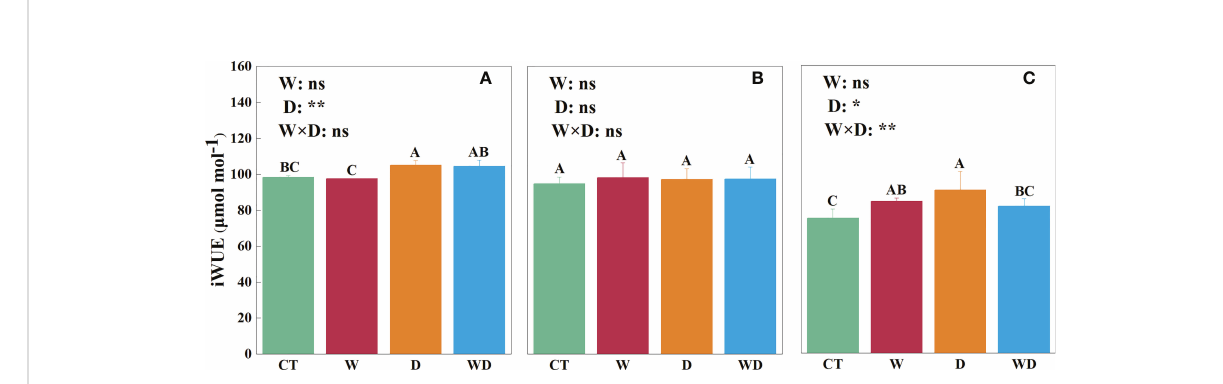
FIGURE 4 Effects of warming and drought on iWUE in the leaves (A) , roots (B) , and litter (C) of C lanceolata . The bars with different letters were signi fi cantly different from each other ( p < 0.05). Treatments: control (CT), warming (W), drought (D), and warming plus drought (WD). Values were mean ± SE ( n = 5); treatment in the combination was expressed as W, warming effect; D, drought effect; and W×D, interactive effect of warming and drought; *, signi fi cant effect at p < 0.05; **, highly signi fi cant effect at p < 0.01; ns, no signi fi cant effect at p >